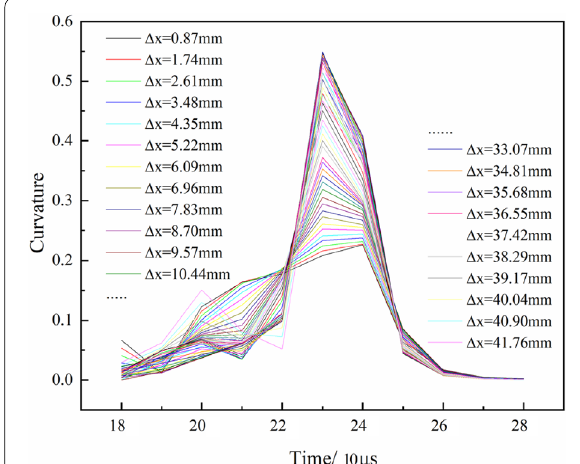
Fig. 16 Curve of ɛ y -t at a typical measuring point on ST line